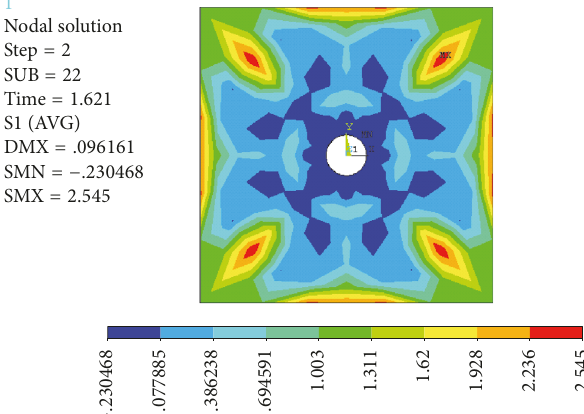
Figure 29: Principal tensile stress on the concrete specimen pre- stressed under a load of 10MPa when the displacement resulting from corrosion-induced expansion reaches 0.011mm.